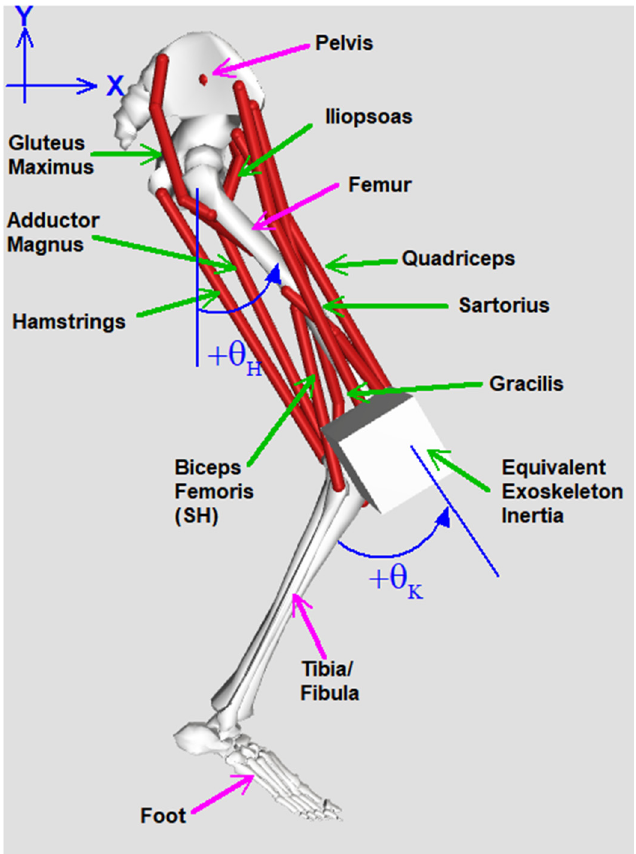
Figure 1. A visualization of the biomechanical model and the relevant axes. Bones represent the modeled mass segments; red lines indicate the modeled muscles; the cube models inertia due to the mass of the actuator. Not shown is the actuator resistance or the actuators themselves.